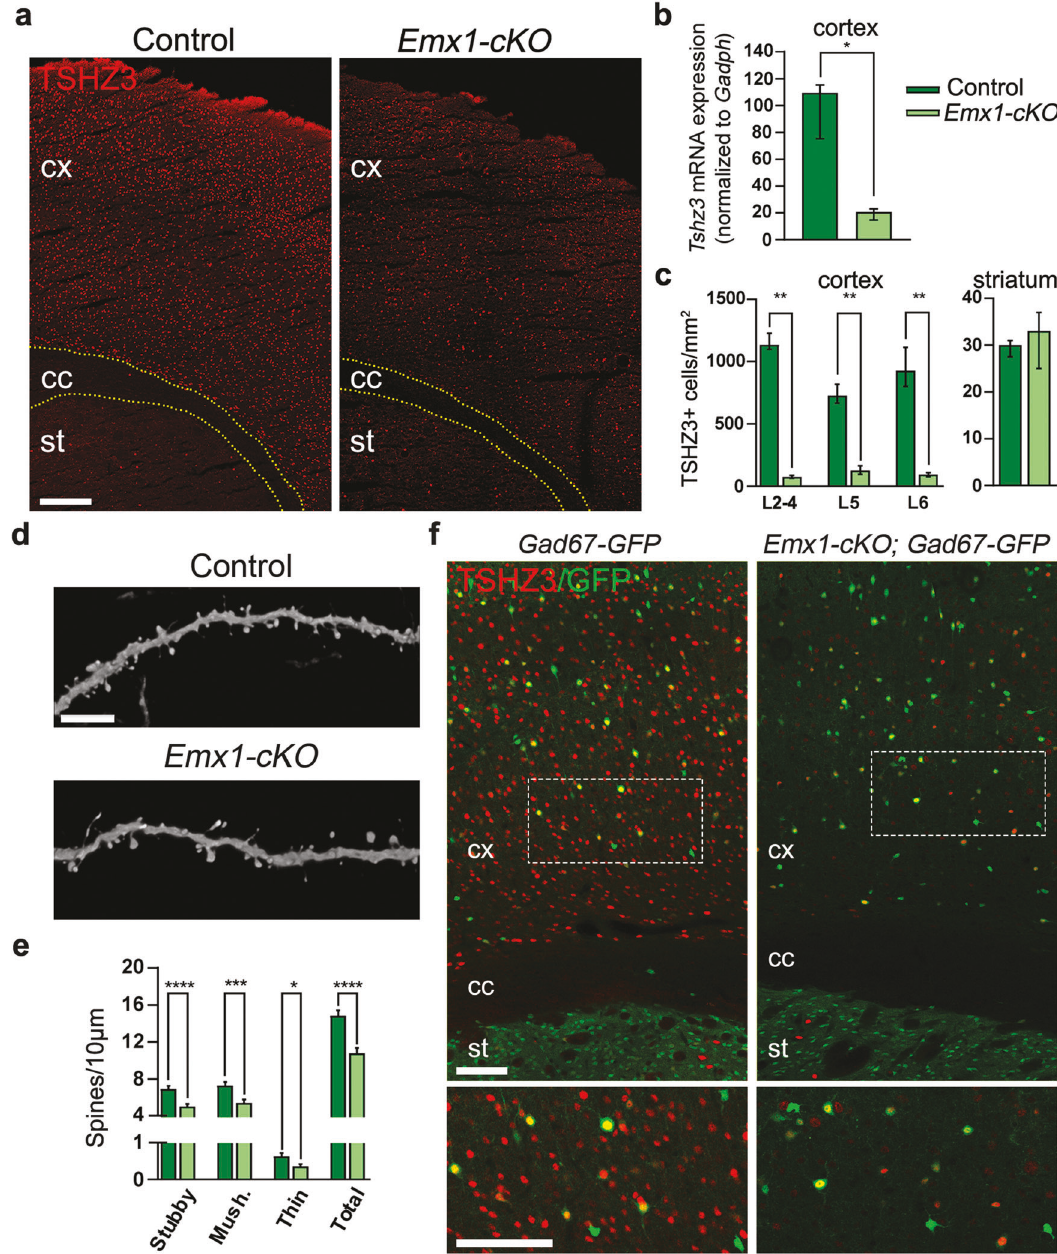
Fig. 1 Conditional Tshz3 deletion in CPNs. a Coronal brain sections from control and Emx1-cKO mice immunostained for TSHZ3. Scale bar 250 µm. b Tshz3 mRNA relative expression in the cortex of control and Emx1-cKO mice measured by RT-qPCR (4 cortices per group; * P < 0.05, Mann – Whitney test). c TSHZ3-positive cell density in control and Emx1-cKO mice in cortical layers (cell counts performed using frames of 400 μ m width spanning from L1 to L6 in 9 sections from 3 control mice and 18 sections from 3 Emx1-cKO mice; ** P < 0.01, Mann – Whitney test) and in the whole striatal surface (cell counts performed in the whole dorsal striatum in 6 sections from 3 control mice and 7 sections from 3 Emx1-cKO mice; P = 0.1496, Mann – Whitney test). d Representative confocal images showing dendritic spines of GFP-positive L5 neurons from control ( Thy1-GFP-M ) and Emx1-cKO ( Thy1-GFP-M;Emx1-cKO) mice. Scale bar 5 µm. e Density of different classes of dendritic spines in control (1688 spines/1135 µm) and Emx1-cKO (1308 spines/1220 µm) mice. f Coronal brain sections from GAD67-GFP control and Emx1-cKO - GAD67-GFP mice immunostained for TSHZ3. Lower panels are magni fi cations of the framed areas in the upper images. Scale bars 100 µm. * P < 0.02, *** P < 0.001 and **** P < 0.0001, Student ’ s t test. Data in ( b ) and ( c ) are expressed as medians with in t erquartile range; data in ( e ) are expressed as means +